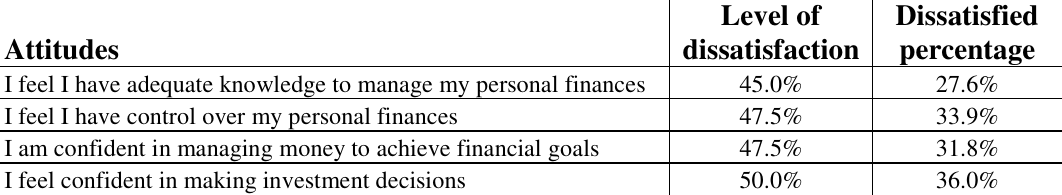
Table 1: Level of dissatisfaction and the percentage of respondents dissatisfied with regard to the different